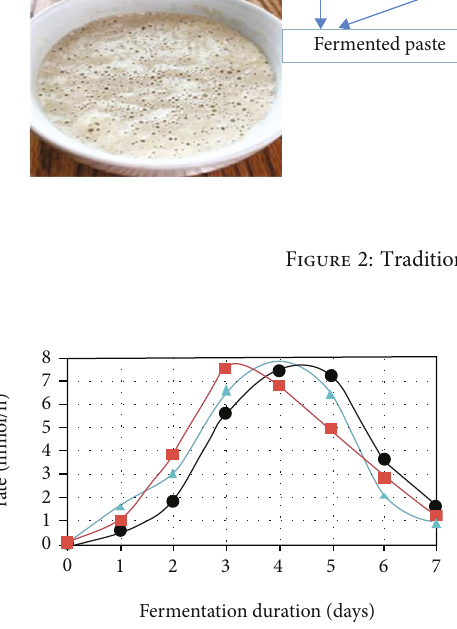
Figure 3: E ff ect of yeast aeration method on the of ethyl alcohol formation rate